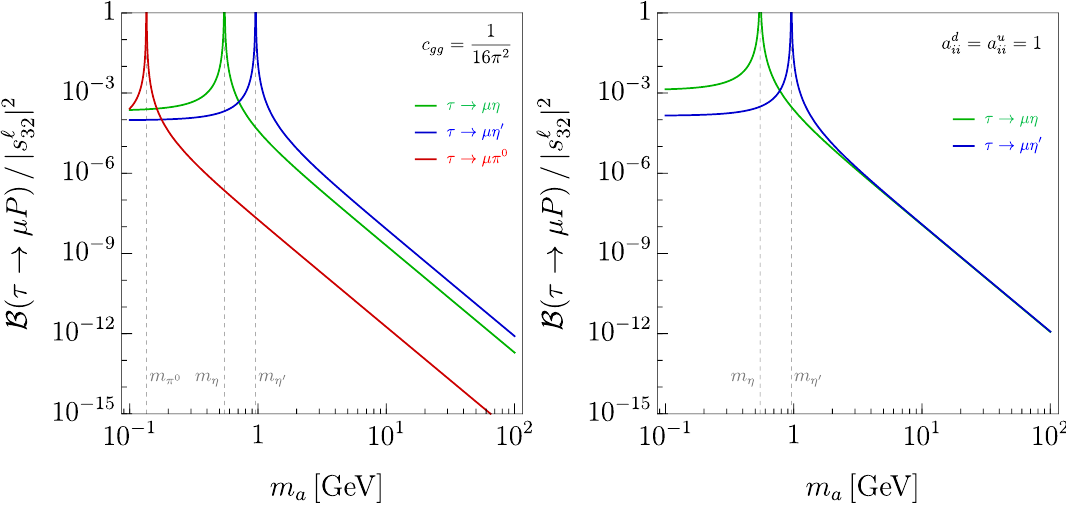
2 plotted against m 0 and ( (cid:28) (cid:22)P ) = s ‘ a for P = (cid:25) 23 j B ! j = a u = 1 (right ii ii